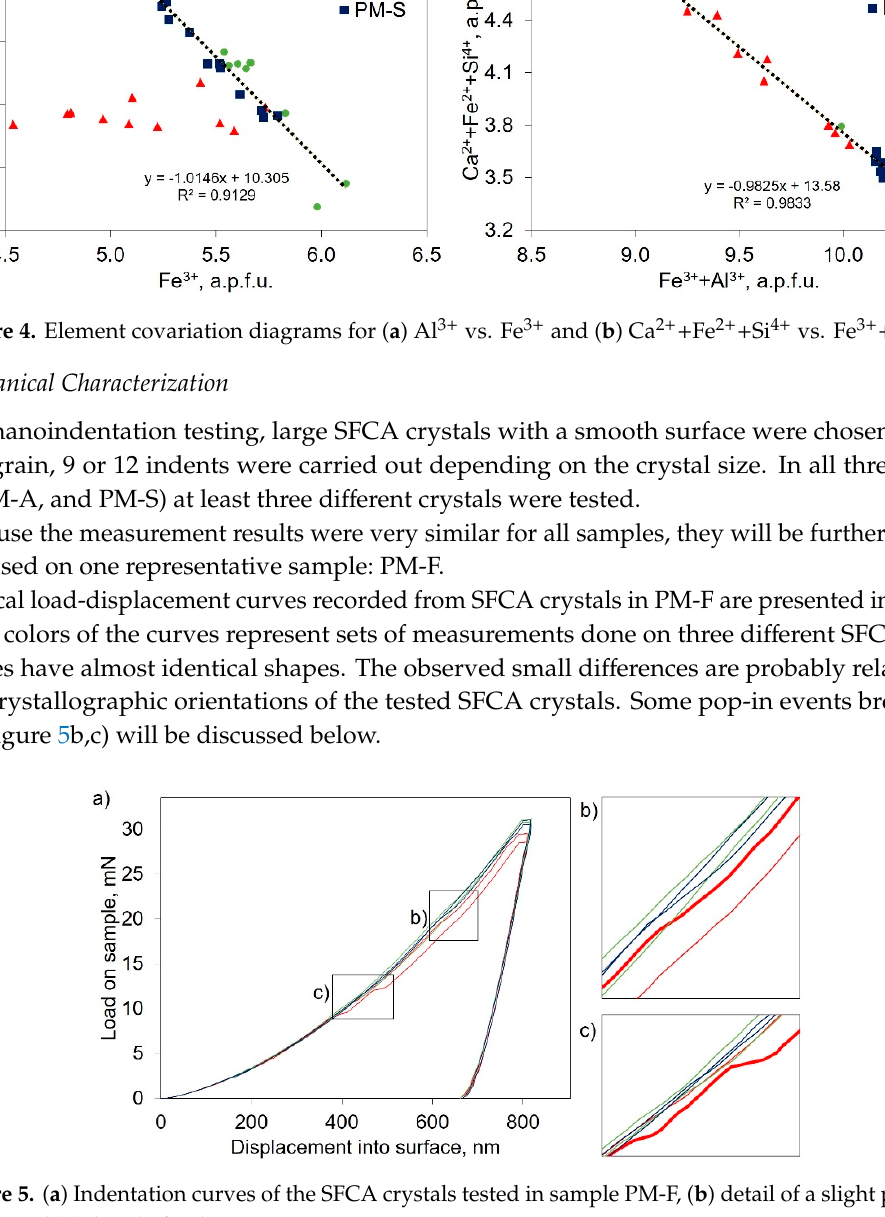
Figure 5. ( a ) Indentation curves of the SFCA crystals tested in sample PM-F, ( b ) detail of a slight pop- in event, and ( c ) detail of a sharp pop-in